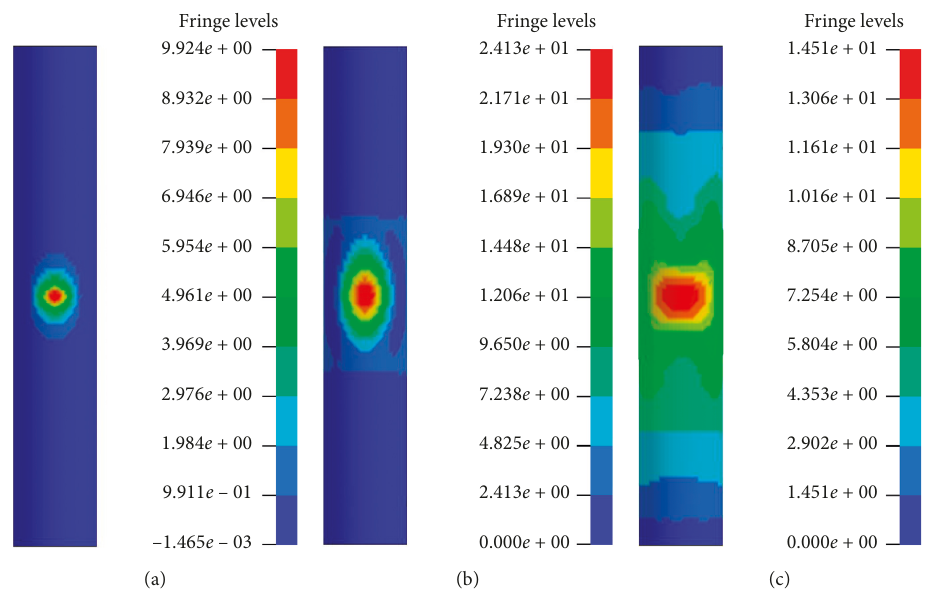
Figure 13: Contours of X -displacement at different time periods (front view): (a) t � 0.4ms, (b) t � 0.9ms and (c) t � 2ms.